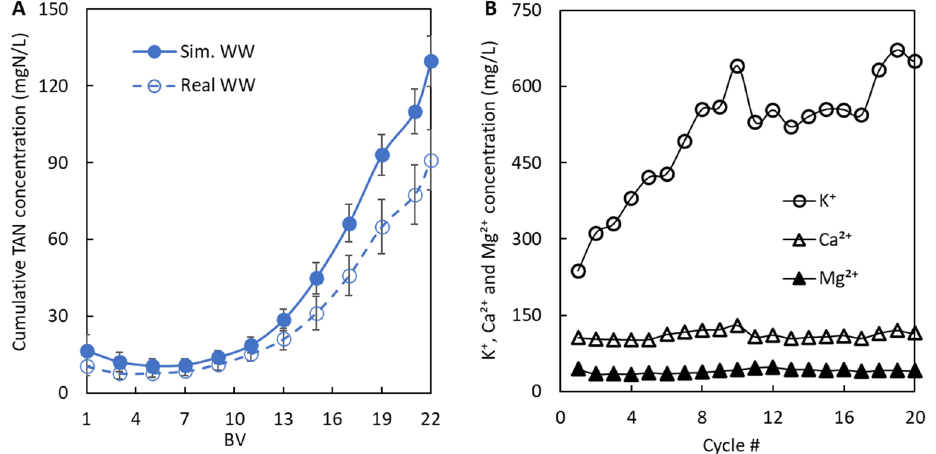
Figure 7. ( A ) Cumulative TAN concentration as a function of the number of bed volumes for the 10 full cycles performed with synthetic wastewater (filled circles), and using the 1st and 2nd batches of real WW (hollow circles). 3 BV/h, n = 10; ( B ) The cations’ composition in the exhausted regeneration solution as a function of completed cycles (cycle #1–10 refers to the synthetic experiment, while cycles #11–20 refers to 1st and 2nd batches of real WW experiments).